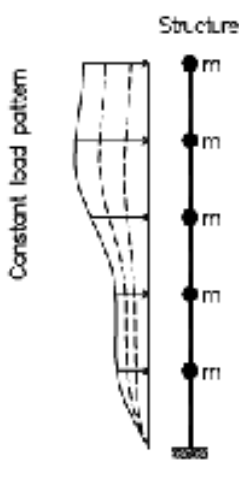
Fig. 3. Load pattern in pushover Figure 3. Load pattern in pushover analysis